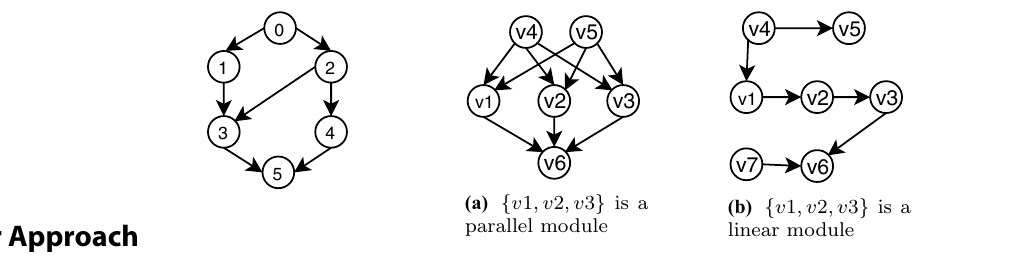
Fig. 2 Example of